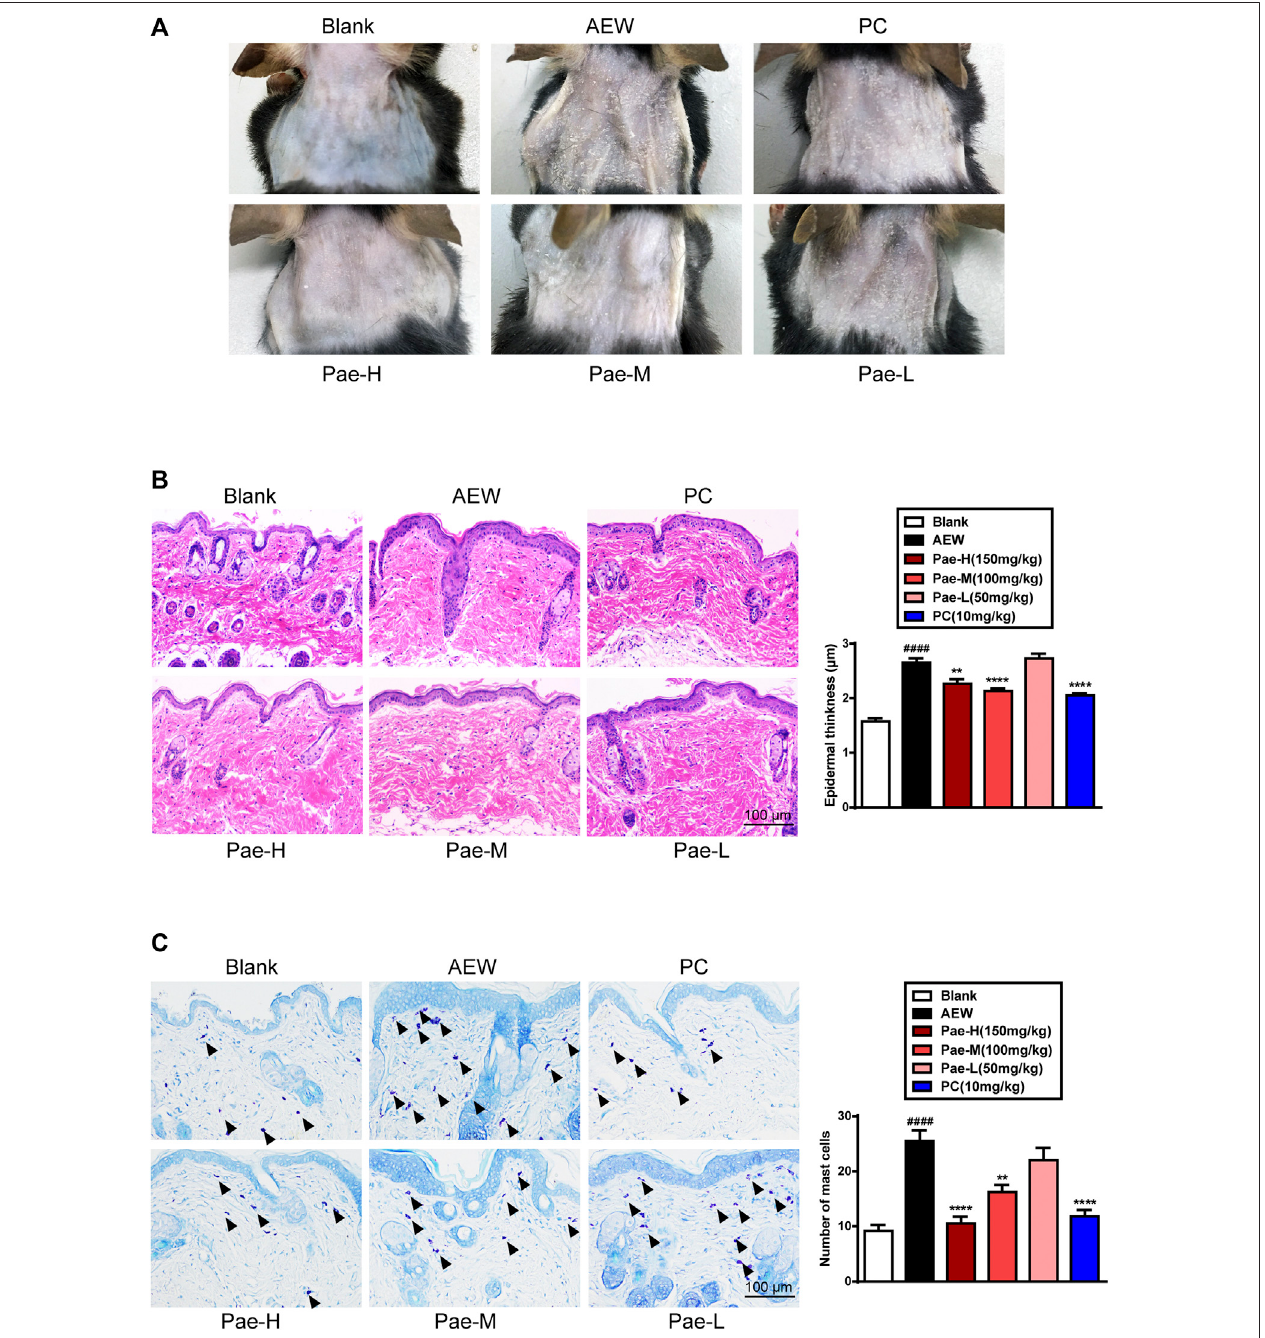
FIGURE2| PaeonolimprovedthepathologicalchangesofdorsalneckskininAEWmice. (A) Therepresentativeimagesofdorsalneckskinofeachgrouponday7. (B) The representative images of Haematoxylin and eosin (H&E) staining and the thickness of epidermis were measured. (C) The representative images of toluidine blue staining and the mast cell number were counted. Data were expressed as mean ± SEM. ### p < 0.001, compared with the blank group; ** p < 0.01, *** p < 0.001, compared with the AEW model group ( n (cid:1) 3 each group).